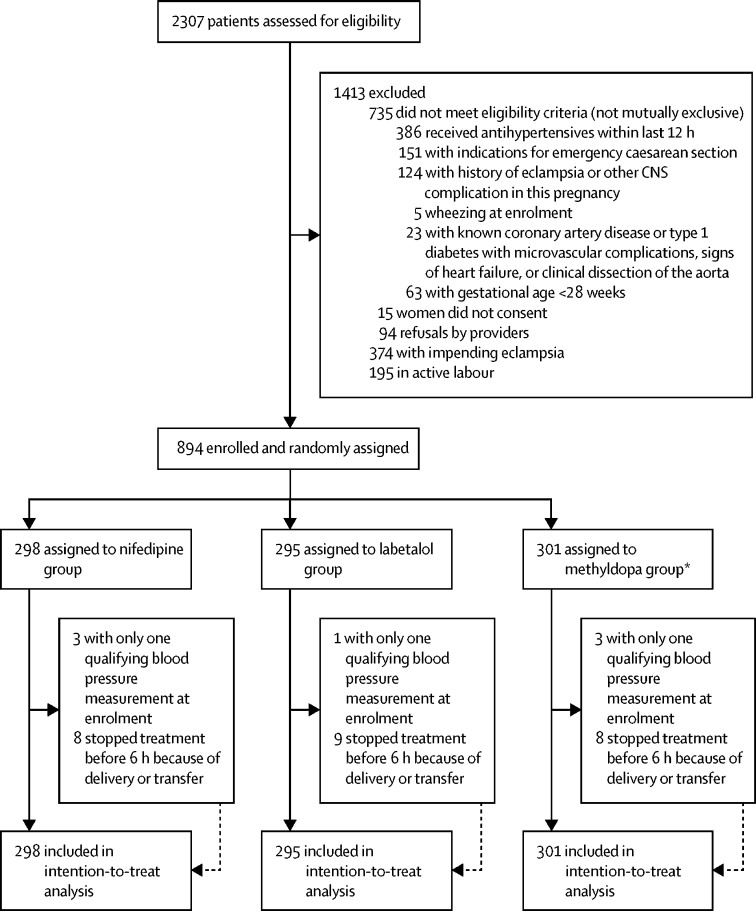
Trial profile*After 6 months of enrolment, the Trial Steering Committee requested an increase in the number of participants in the methyldopa group, because a large cohort study suggested the drug was more effective than originally estimated.17 Thus, we increased the number in the methyldopa group from 75 women to 298 women.